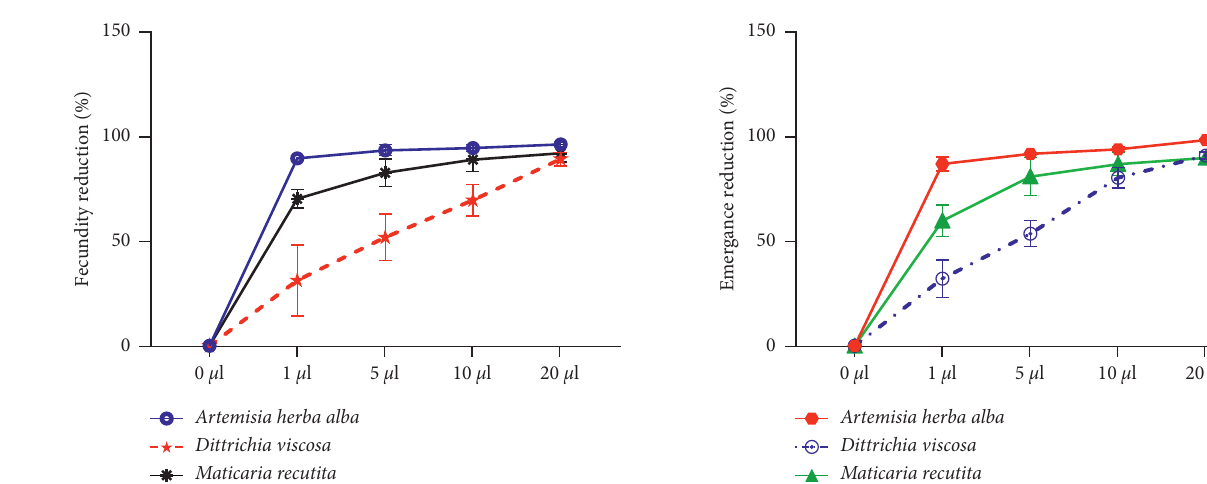
Figure 14: Rate of the reduction of Callosobruchus maculatus Fab. emergence under the effect of essential